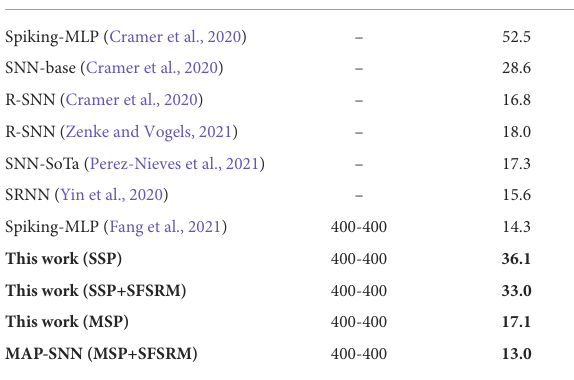
TABLE 3 Performance of different algorithms on